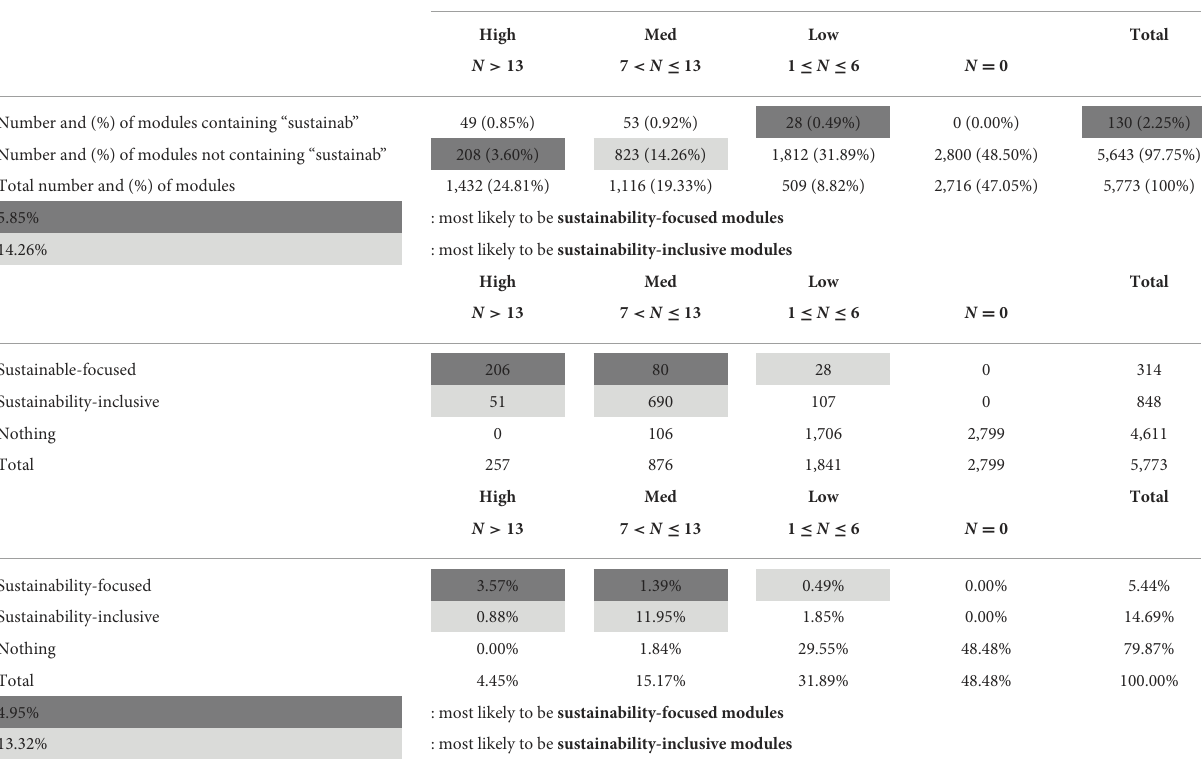
TABLE 7 Probability analysis of “sustainability-focused” modules and “sustainability-inclusive” modules.